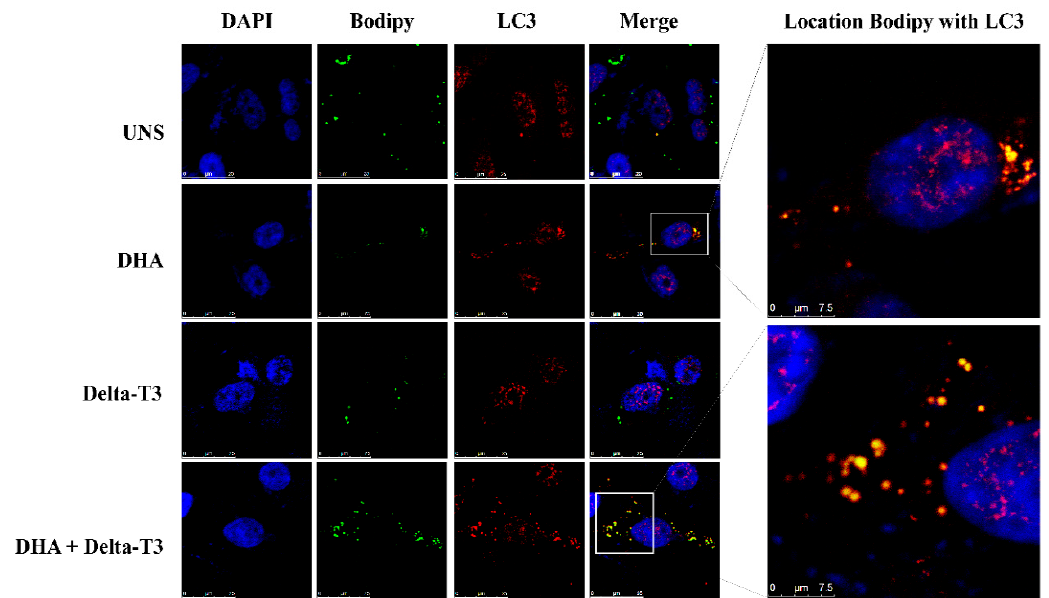
Figure 5. Lipophagy process analyzed in MDA-MB-231 cells treated with DHA (50 µ M), Delta-T3 (5 µ M) and co-treatment assessed by confocal microscopy images (63 × ). LD are shown in green (Bodipy staining) and LC3-B is shown in red. Cell nuclei are shown in blue (DAPI staining). Images are representative of three independent experiments.